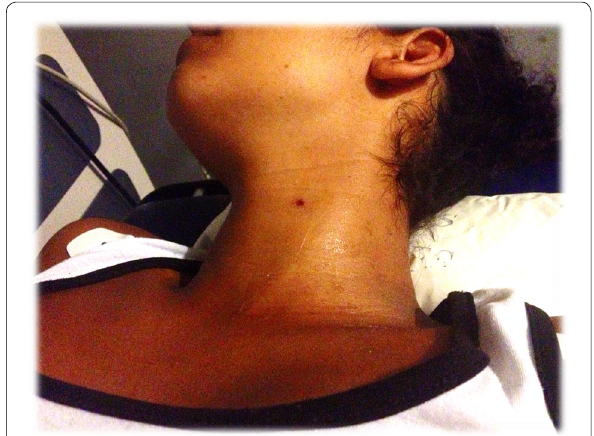
Fig. 1 Gunshot wound to the neck